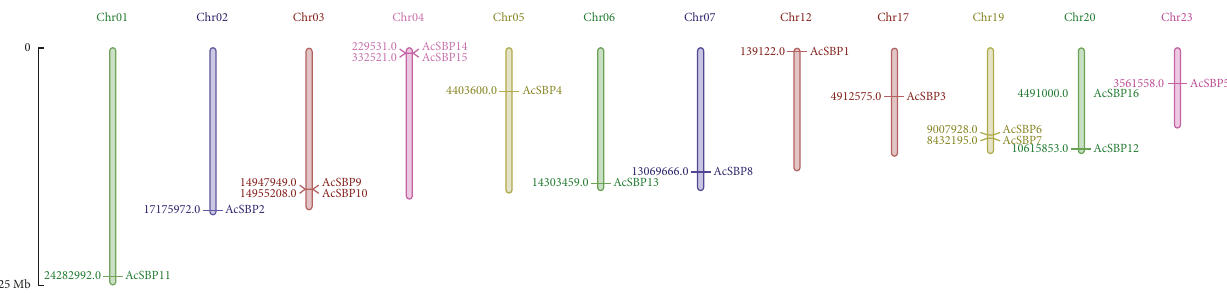
Figure 2: Distribution of SBP genes in pineapple genome. Mapinspect was used to locate genes on the chromosome. Gene start point is shown on the chromosome, while gene sizes are shown in megabases (Mb) against each